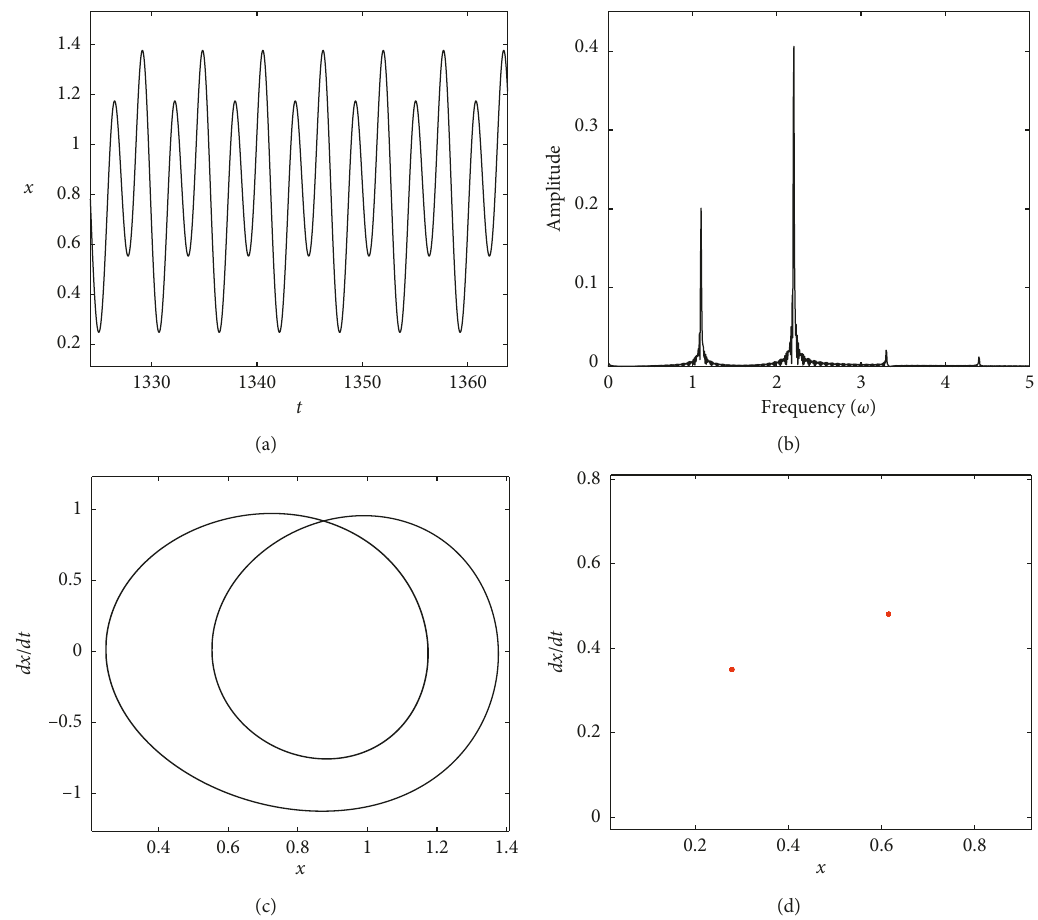
Figure 11: System response at ω � 2.2rad/s and F � 1.5 N: (a) time history; (b) frequency spectrogram; (c) phase portrait; (d) Poincare maps.